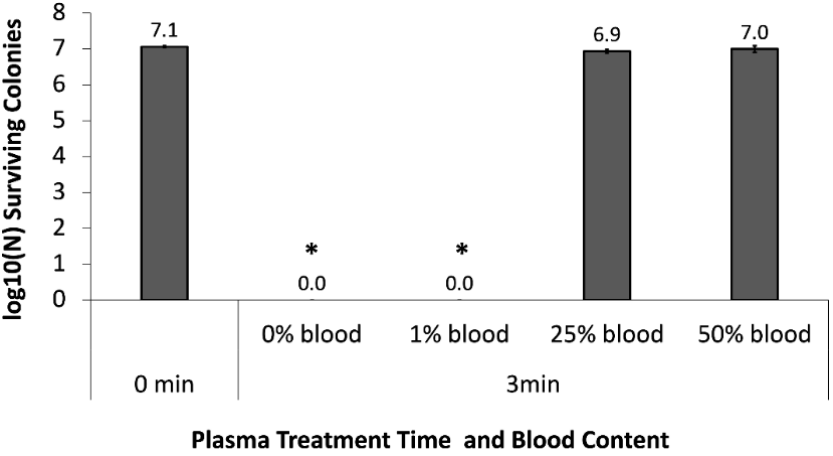
Figure 3. Effect of 1%, 25%, and 50% of blood content on the antimicrobial efficacy of 3-min plasma- treated NAC. * denotes p -vaue < 0.05.